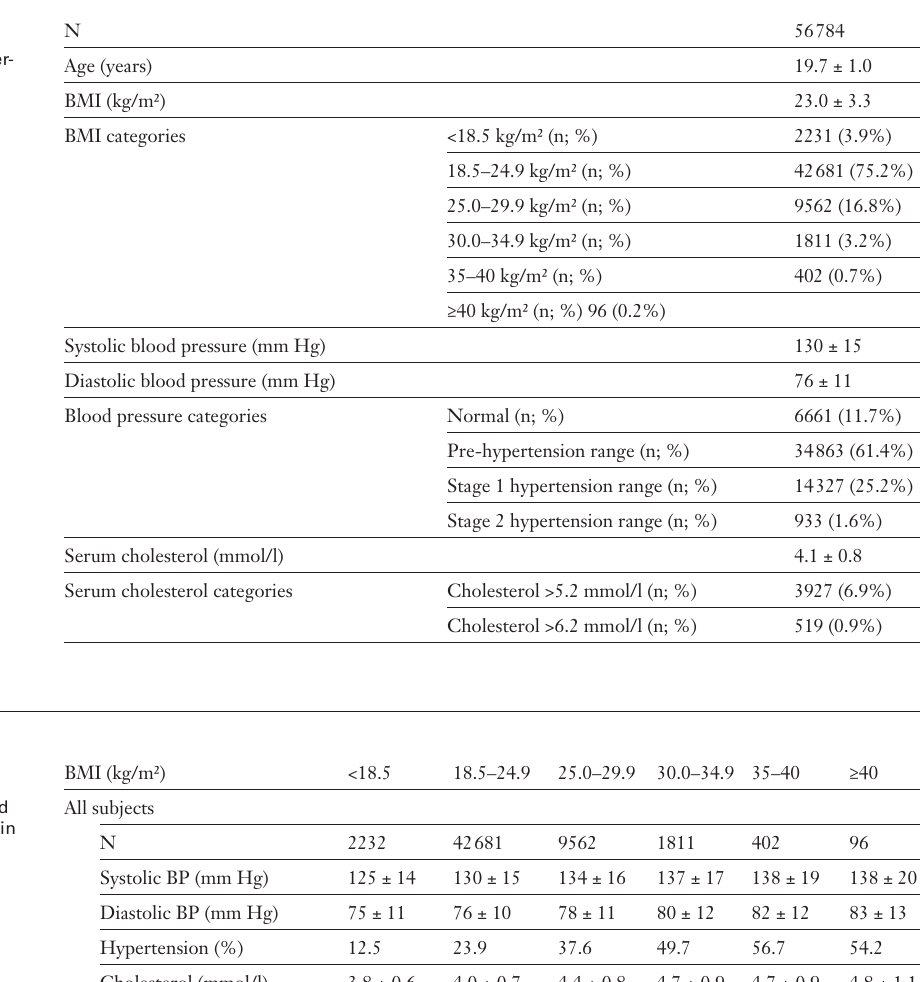
Important character- istics of the study population.